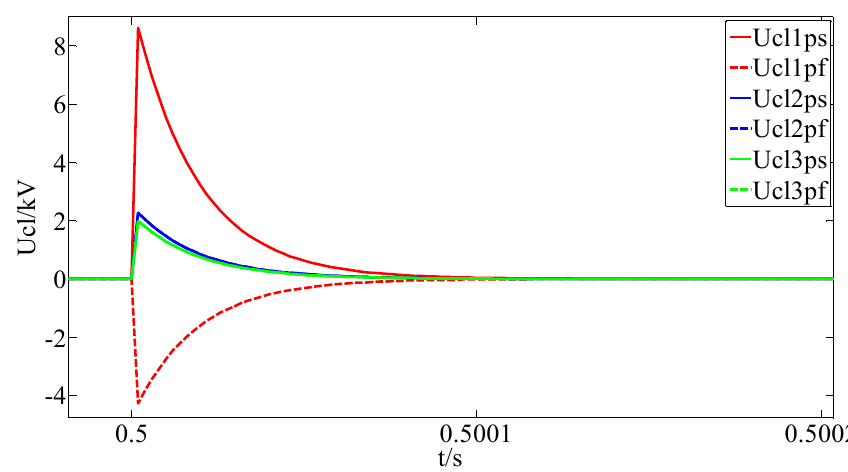
Figure 8. Simulation results of the CLI voltages during a high-resistance pole-to-pole fault. Table 4. Voltage change rates of the CLIs during a high-resistance DC